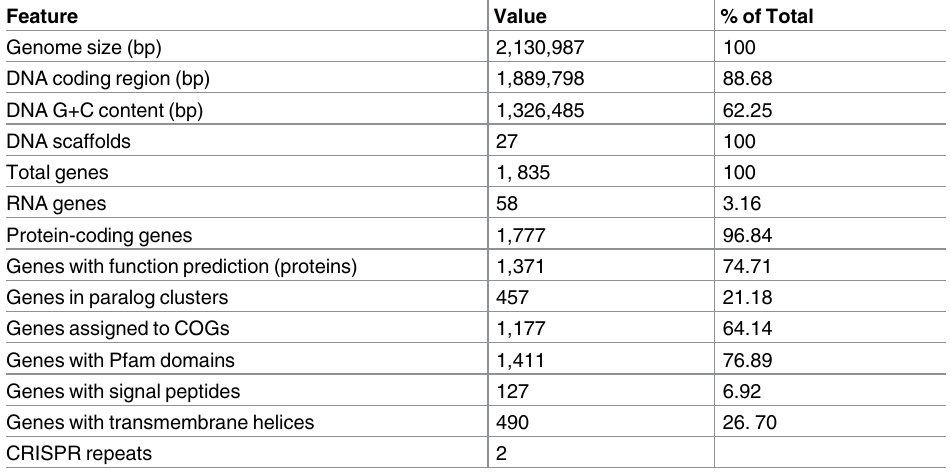
Table 1. General genome characteristics of Actinotignum schaalii DSM 15541 T